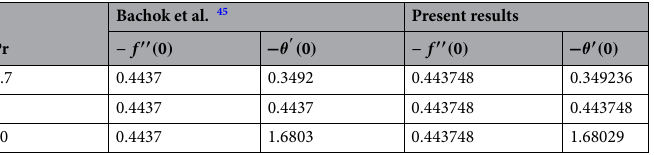
Table 2. Variations of the skin friction f ′′ ( 0 ) and local Nusselt number θ ′ ( 0 ) for several sets of physical